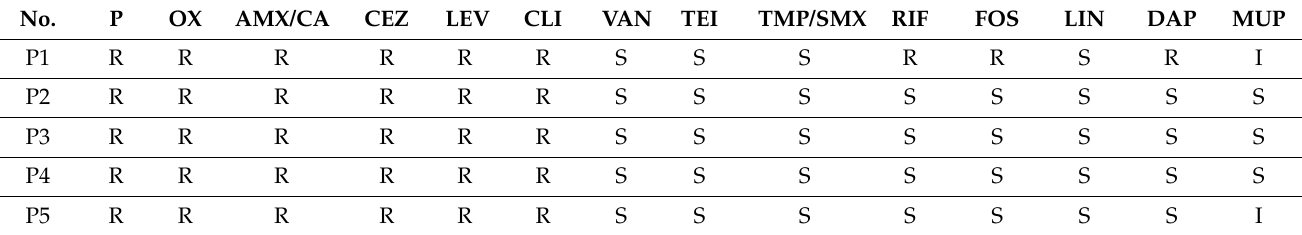
Table 2. Susceptibility testing results of methicillin-resistant S. aureus (MRSA) detected in patients.